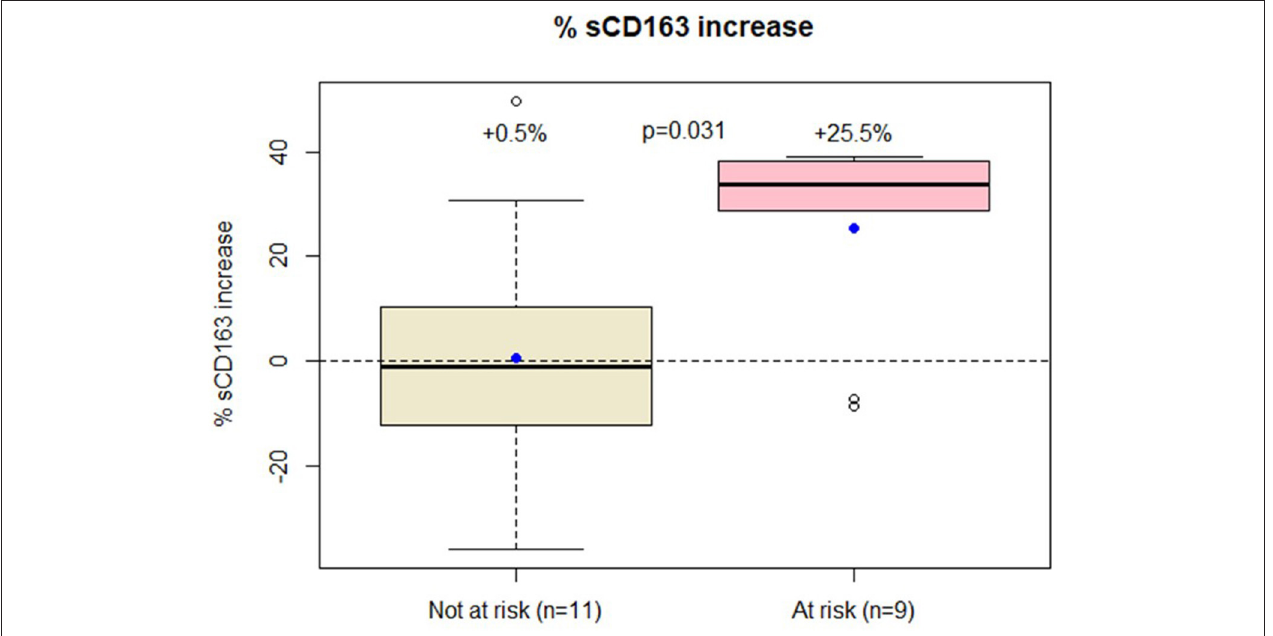
FIGURE 1 | Patients at low risk of immune activation had only modest increase in sCD163 trajectory while those at high risk had over 25% increase in sCD163 values.